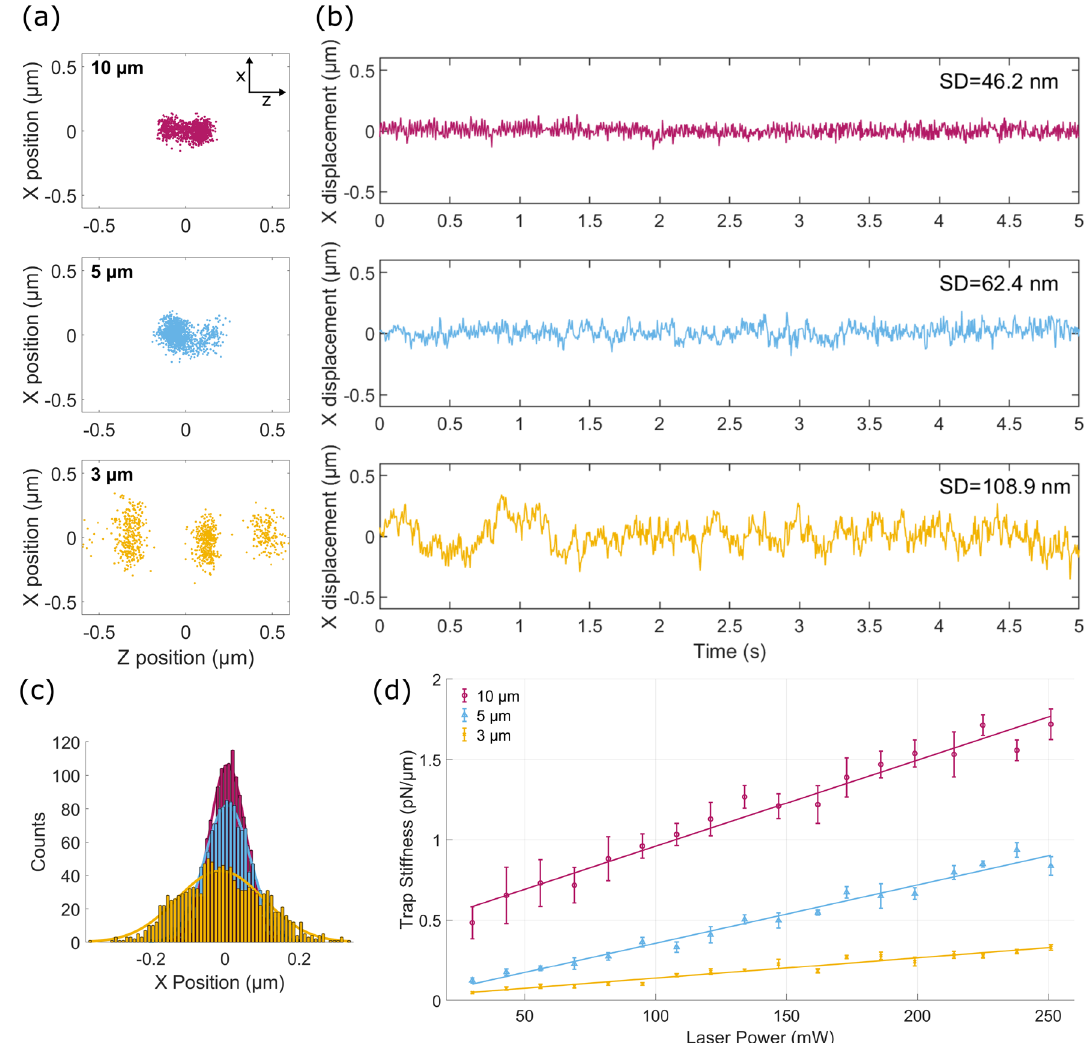
Figure 4. ( a ) Representative results for the X-Z position plot of the optically trapped particles at laser power, P = 240 mW from each beam. ( b ) Plot of the position fluctuation in X axis as a function of time. ( c ) Histogram of the position of the trapped particles at P = 240 mW. ( d ) Plot of the transverse trap stiffness for 3, 5 and 10 µ m sized particles measured for different incident laser power from each fiber. Each data point is an average of n=5 trapped particles and error bars are ± 1 standard